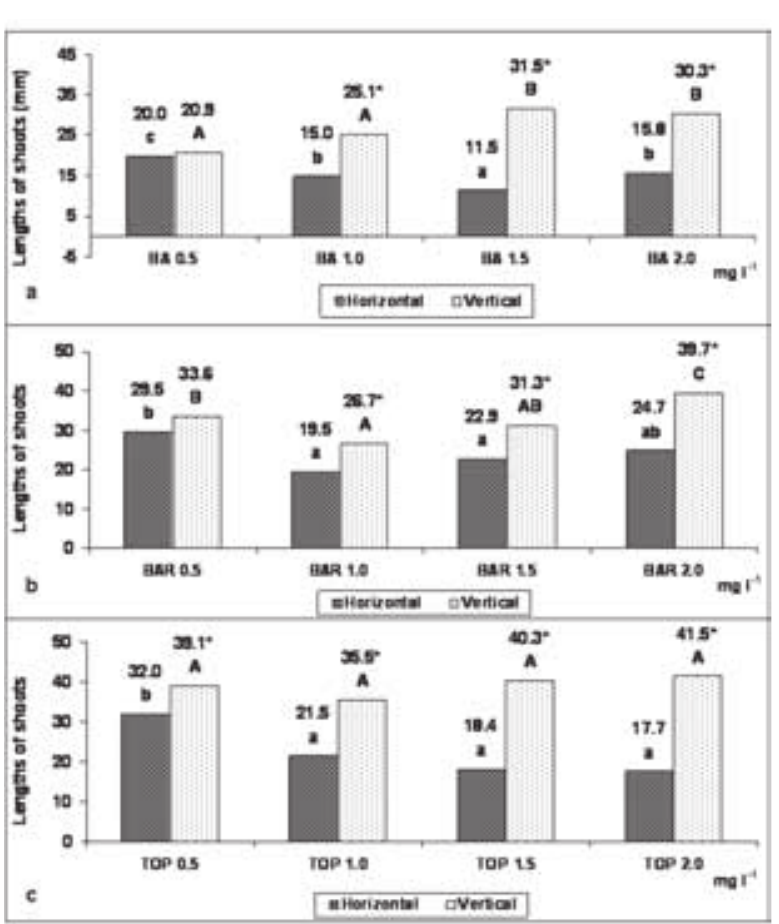
Fig. 2. The effects of explant positions and cytokinin concentrations on the length of shoots of Asparagus offi cinalis ’Grolim’. Signifi cant differences (P<0.05) between different explant positions are indicated by * at the same cytokinin treatment. Signifi cant differences (P<0.05) between different cytokinin concentrations are indicated by small letters in the case of horizon- tal position of explants and by capital letters in the case of vertical position of explants Table 1. The main effects of the cytokinin types on the multiplication rate and shoot length of A. offi cinalis ‘Grolim’. Signifi cant differences (P<0.05) between different cytokinin treatments are indicated by small letters within a column Explant